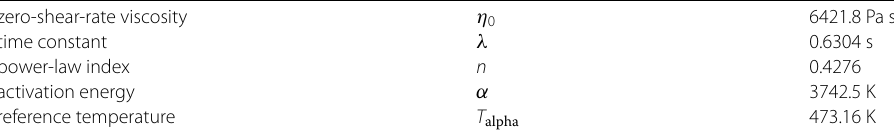
Table 2 Cross model coefficients to model the viscosity of Polypropylene (PP) in Fig. 6 zero-shear-rate